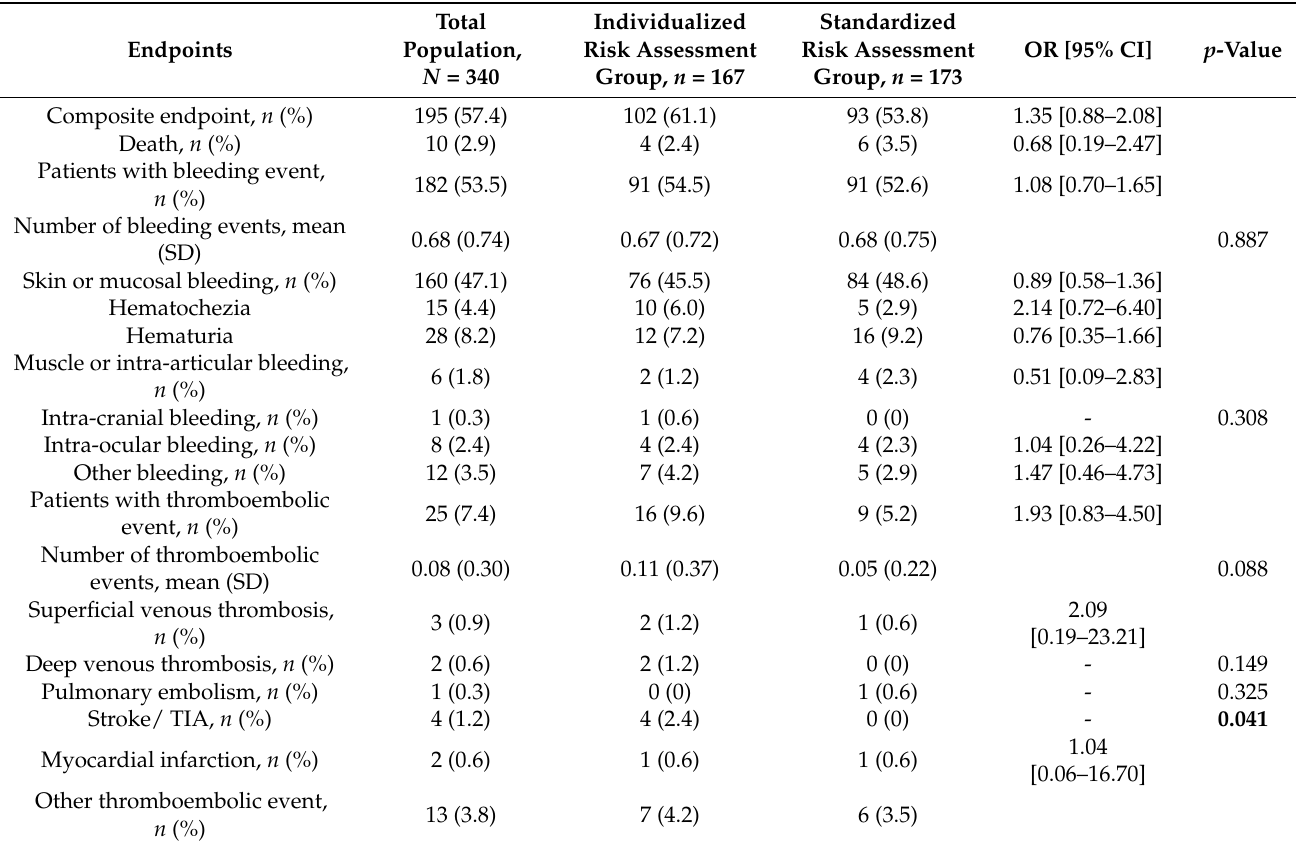
Table 2. Frequencies and unadjusted odds of study endpoints ( N =